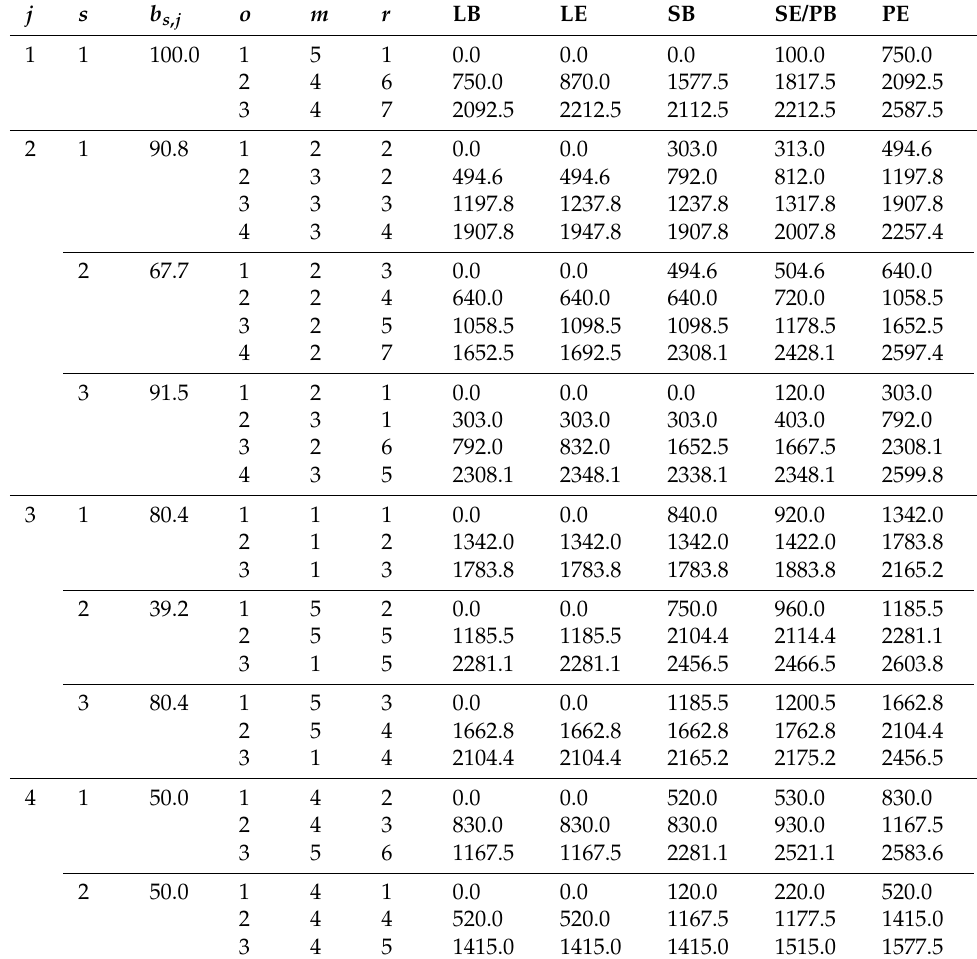
Table 4. Operation scheduling for Problem-1.